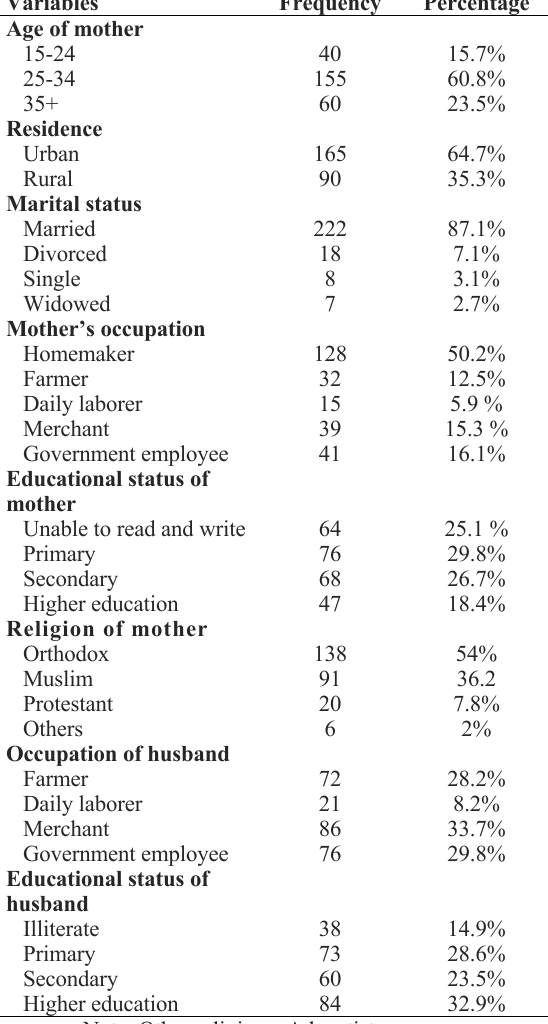
Note: Other religions=Adventist Table 1. Sociodemographic characteristics of mothers with infants less than 24 months of age in Woldia General